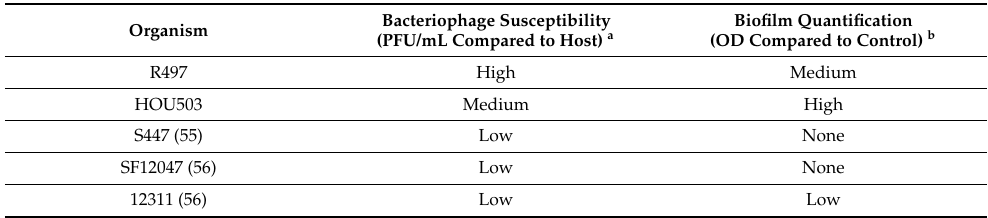
Table 1. High, medium, and low phage susceptibility were defined as phage counts of >10 7 , between 10 3 and 10 7 , and <10 3 PFU/mL,